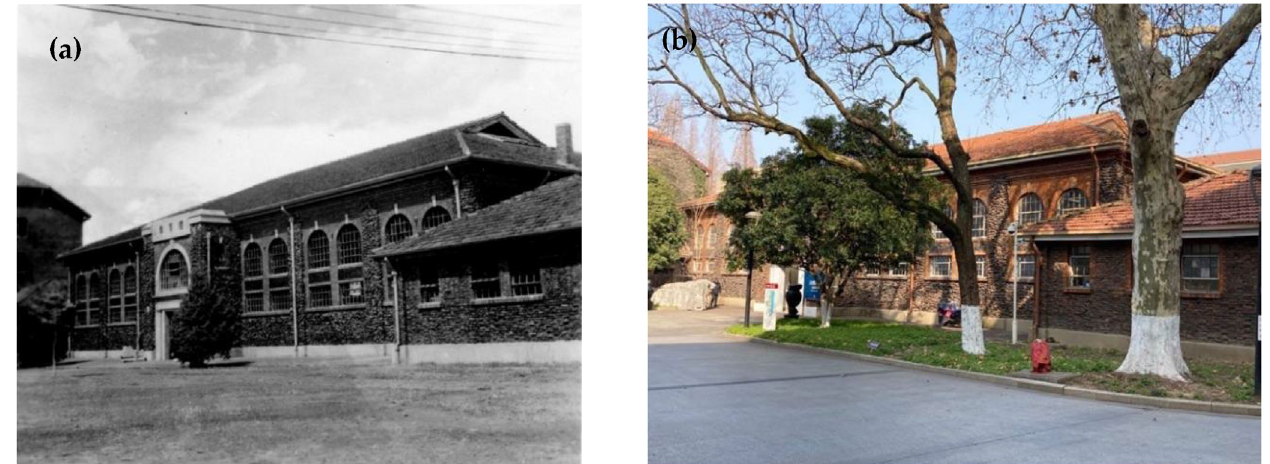
Figure 3. ( a ) Smart Memorial Gymnasium in the early 20th century (Source: Special Collections,